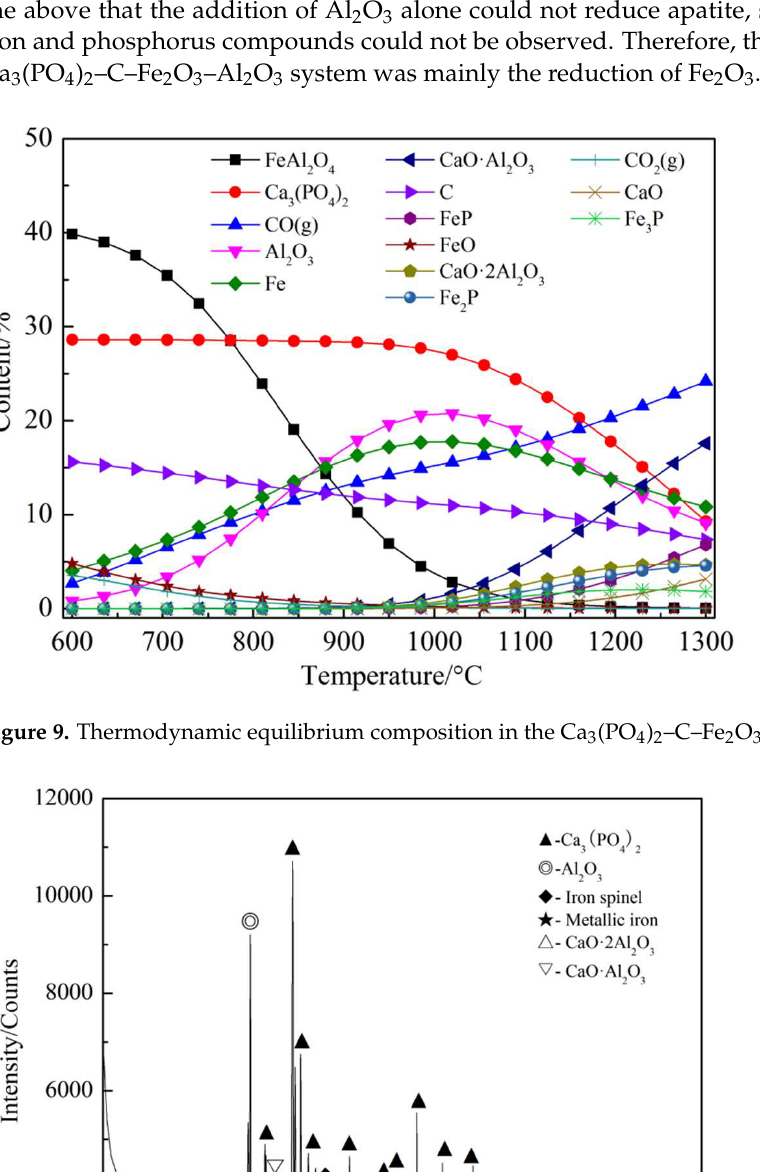
Figure 10. XRD analysis of the Ca 3 (PO 4 ) 2 –C–Fe 2 O 3 –Al 2 O 3 system after coal-based reduction.